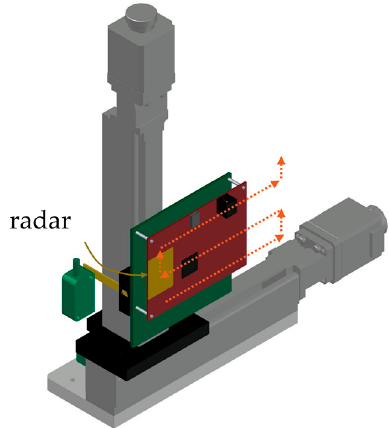
Figure 4. Scheme of the 3D GBSAR prototype used for the experiment. Orange arrows evidence the scan directions.